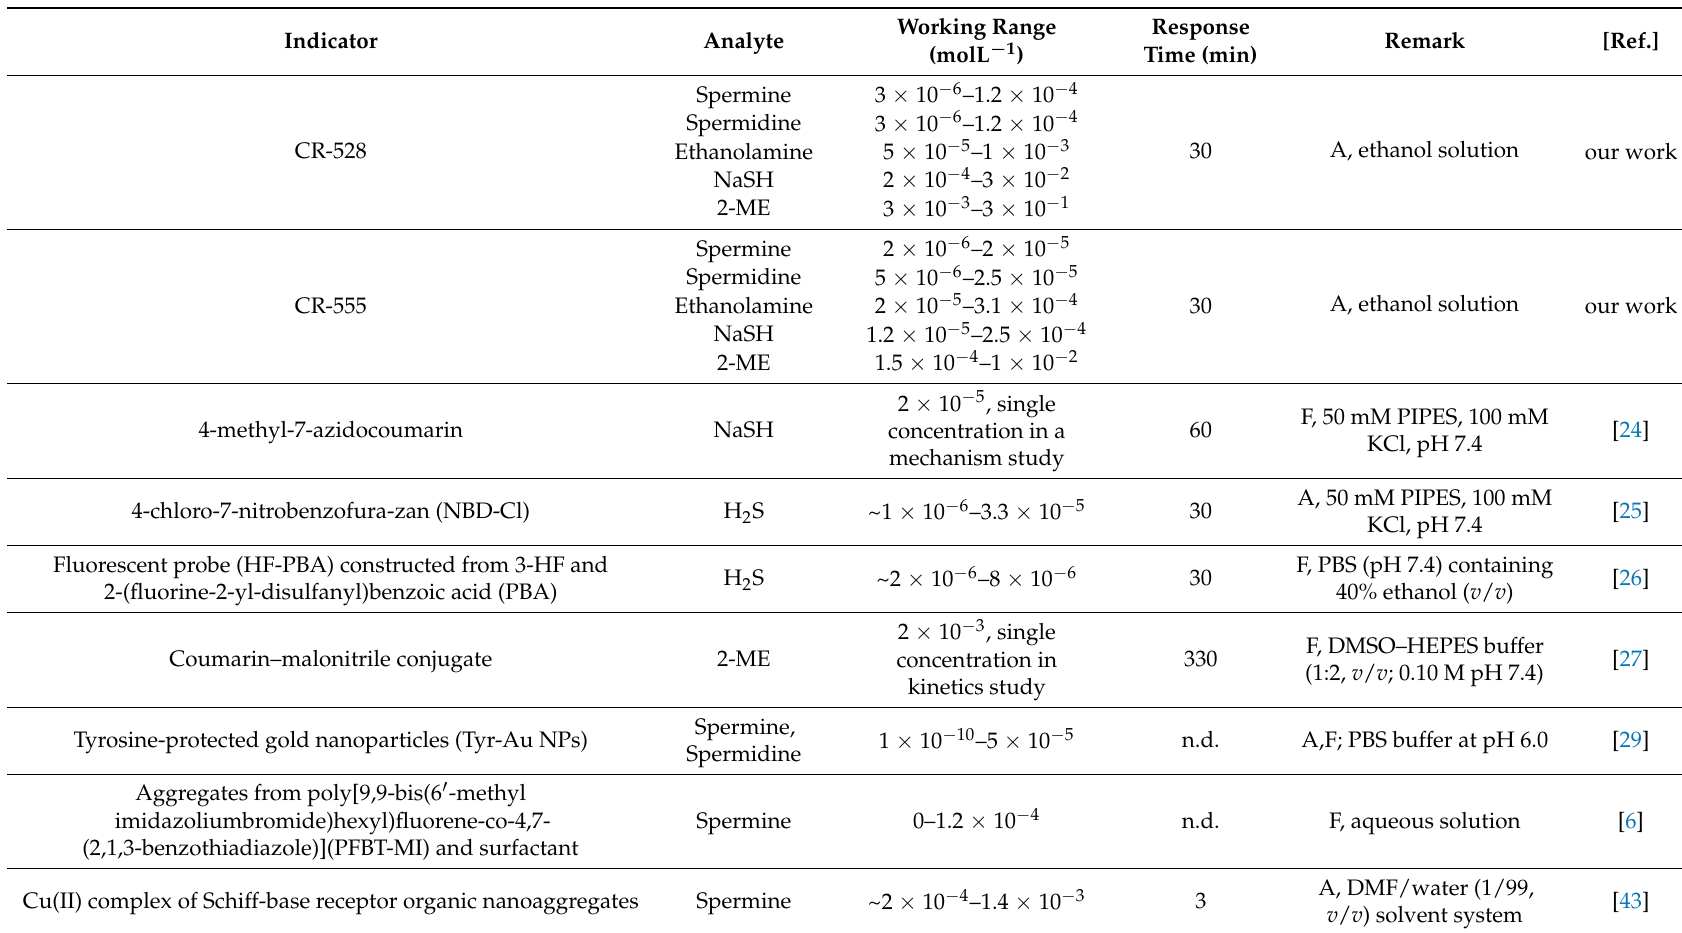
Table 2. Comparison data of developed probes for the detection of relevant sulfur-containing analytes and biogenic